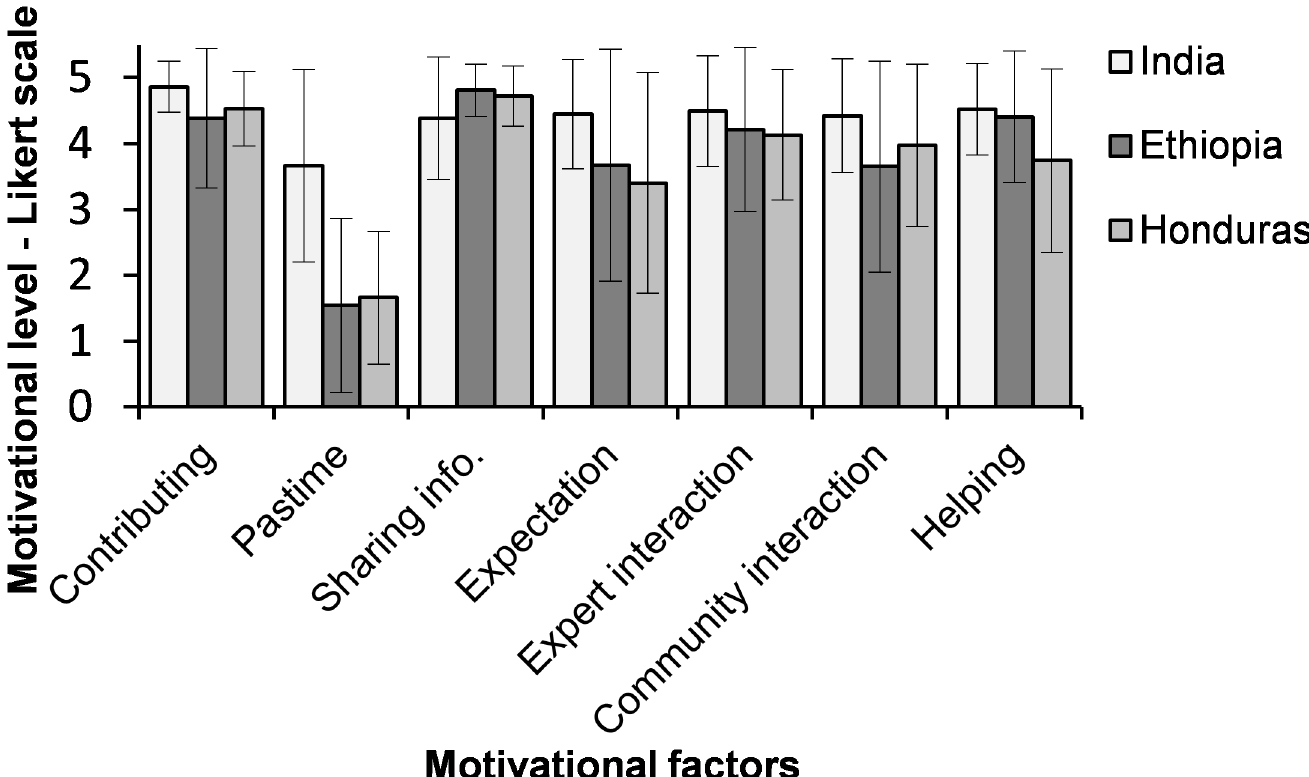
Fig 2. Motivational factors of farmersin the three countries (India, Ethiopia and Honduras) to participate in the crop improvement trials as citizen scientists.